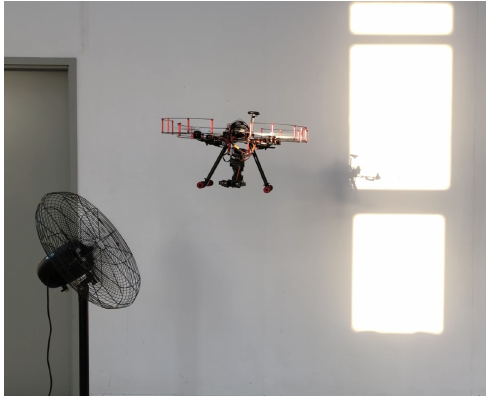
Figure 17. Experimental